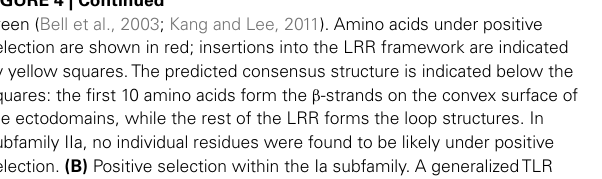
FIGURE 4 | Continued green (Bell et al., 2003; Kang and Lee, 2011). Amino acids under positive selection are shown in red; insertions into the LRR framework are indicated by yellow squares.The predicted consensus structure is indicated below the squares: the first 10 amino acids form the β -strands on the convex surface of the ectodomains, while the rest of the LRR forms the loop structures. In subfamily IIa, no individual residues were found to be likely under positive selection. (B) Positive selection within the Ia subfamily. A generalizedTLR